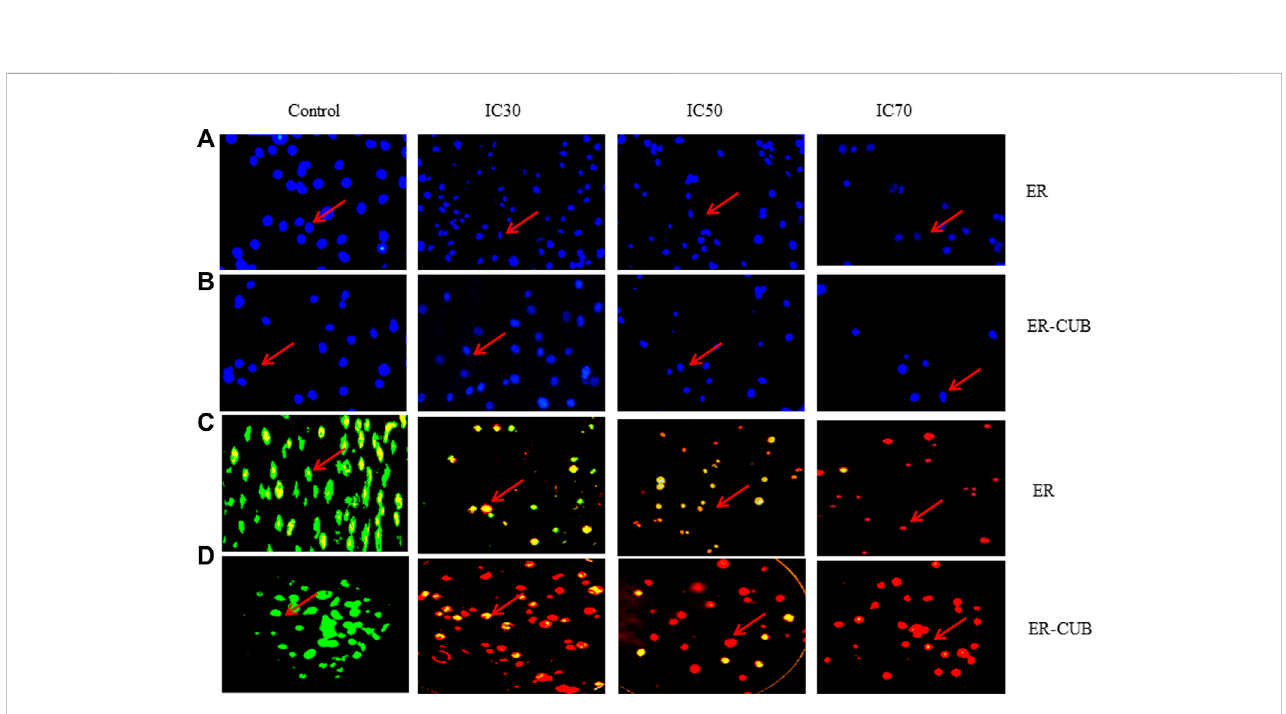
FIGURE 8 Invitro cytotoxicityofER,andER-CUBinEACcancercellsafter24 hofincubationbyMTTassay.Valuesaremean±SD( n =3),* p < 0.05,** p < 0.01 versus ER treatment at same dose. EAC cancer cells stained with Hoechst IC30, IC50 and IC70 images of acridine orange and ethidium bromide staining of EAC cancer cell line.